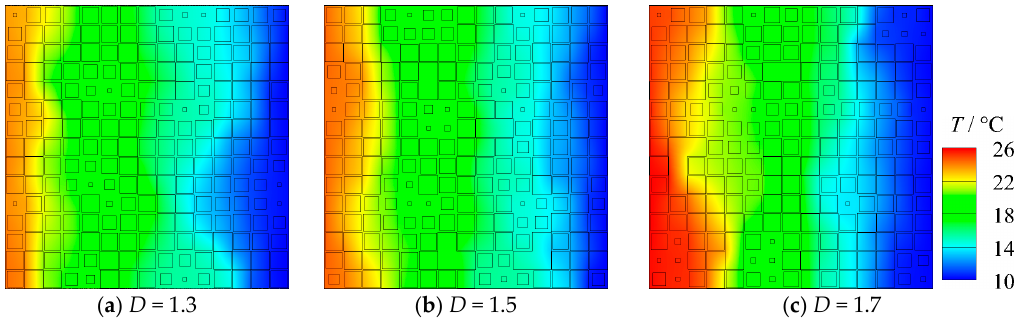
Figure 10. Effect of fractal dimension on the temperature distributions of porous material: ( a ) D = 1.3; ( b ) D = 1.5; ( c ) D = 1.7.